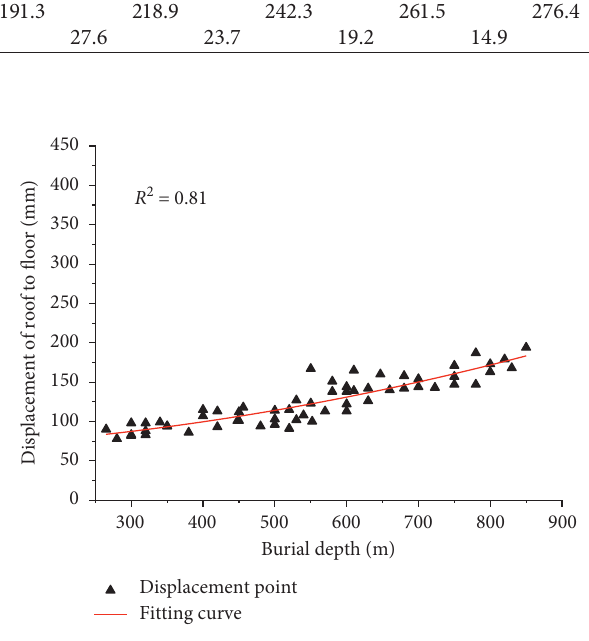
Figure 19: 40m away from the working face.